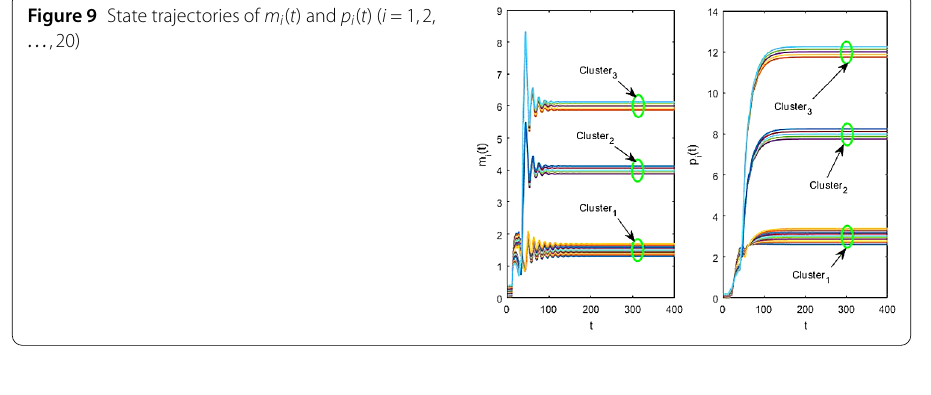
Figure 9 State trajectories of m i ( t ) and p i ( t ) ( i = 1,2, ...